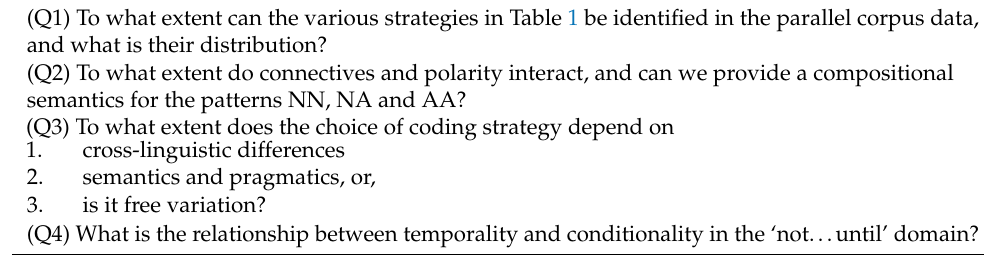
Table 2. Research questions addressed